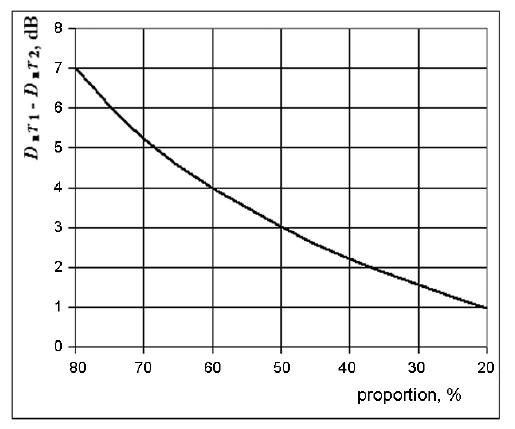
Fig. 3. Changes in D n T values in case when the receiving room’s volume is reduced on the some proportion of initial volume